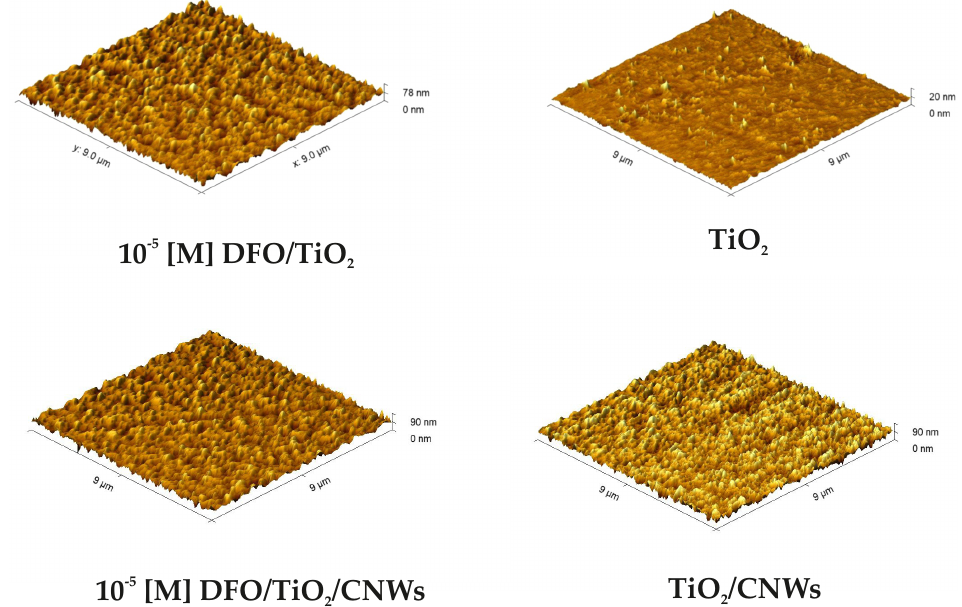
Figure 2. AFM image of thin films of DFO/TiO 2 and DFO/TiO 2